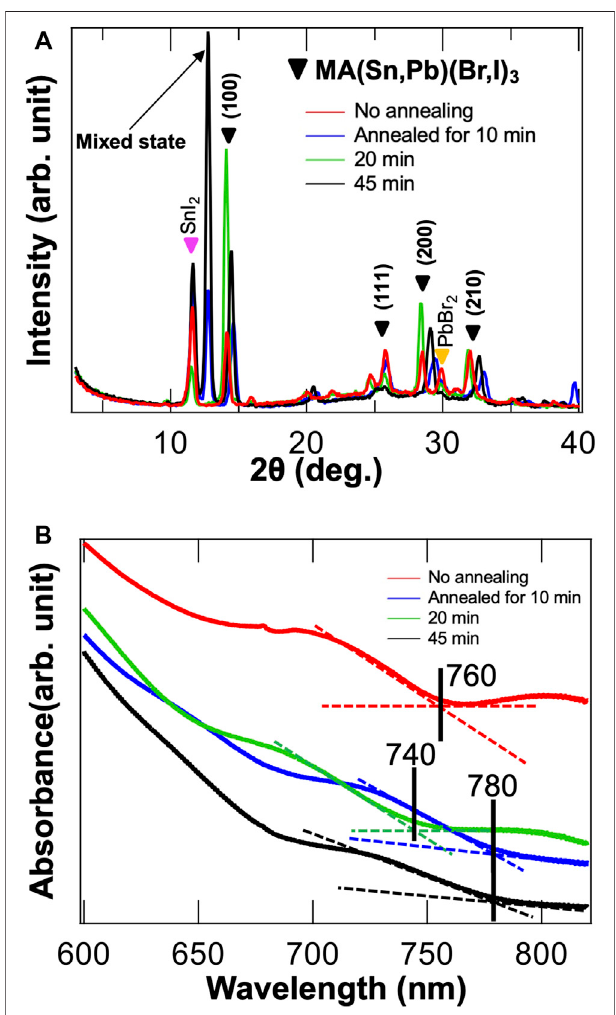
FIGURE 4 | (A) XRD results. The SnI 2 and PbBr 2 are still present. In the 10-min annealing sample, the perovskite structure is observed. The mixed states are remarkably prominent in the 45-min annealing sample. (B) Optical band gap is approximately measured with 1.65 eV in UV-Vis